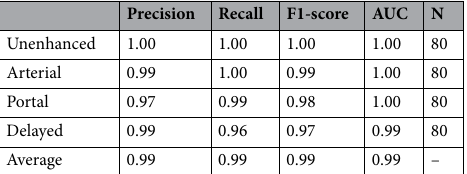
Precision Recall F1-score AUC N Unenhanced